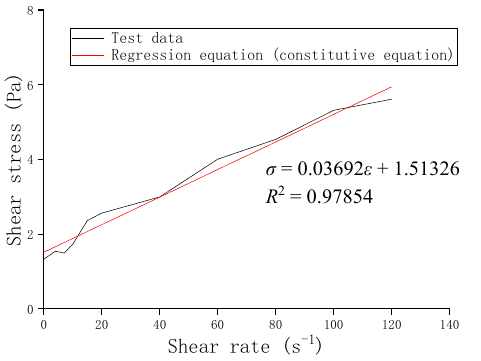
Figure 8. CAH new cement slurry constitutive model (shear stress–shear rate curve). The correlation coefficient is 0.97854, indicating that the fitting effect is good. The cohesive force of the cement slurry, which is the intercept of the curve on the y-axis, has a value of 1.51326 Pa, which is also in good agreement with the research of Wu [4,11].